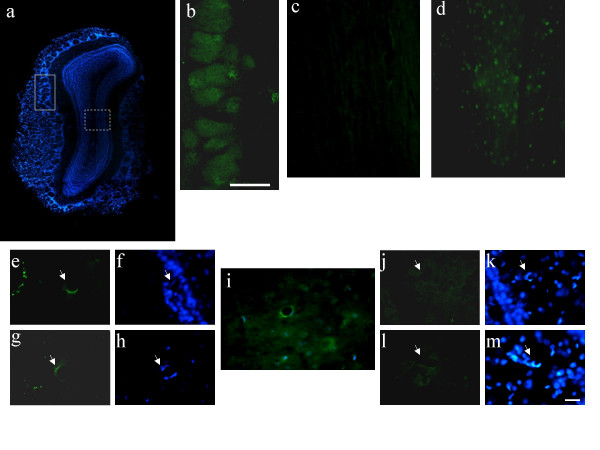
P75NTR expression in the lesioned olfactory bulb: Olfactory bulb sections from sham and NMDA lesioned animals that were either estrogen or control-pellet replaced were probed for p75NTR expression and counter-stained with a nuclear dye (DAPI). A low magnification photomontage of olfactory bulb illuminated for DAPI is shown in (a). P75NTR is normally expressed in the glomerular layer of the olfactory bulb (b), photographed from the region indicated by the solid line box in (a). P75NTR is poorly expressed in other regions of the olfactory bulb, an example of which is shown in (c), taken from the region indicated by the wire frame in (a). However, in a comparable region of the NMDA-lesioned animals, diffuse p75NTR staining is seen in cells and fibers at the injury site (d). In estrogen-treated, lesioned animals p75NTR immunoreactivity is seen in cells associated with the walls of microvessels (e; g), identified by their curved nuclei (f; h) surrounding a lumen. Arrows indicate the same cells photgraphed under fluorescein (p75NTR; e,g) or UV illumination (DAPI nuclear dye; f,h). A double-labeled cell photographed under both fluoresein and UV is shown in (i). P75NTR labeling was not seen in microvessel walls in lesioned animals that received a control pellet (j) or in sections from estrogen-replaced lesioned animals that were incubated without a primary antibody (immunohistochemical control, l). Corresponding nuclear dye images are in k and m. Magnification bar: b-d = 160 μm; e-m = 25 μm.